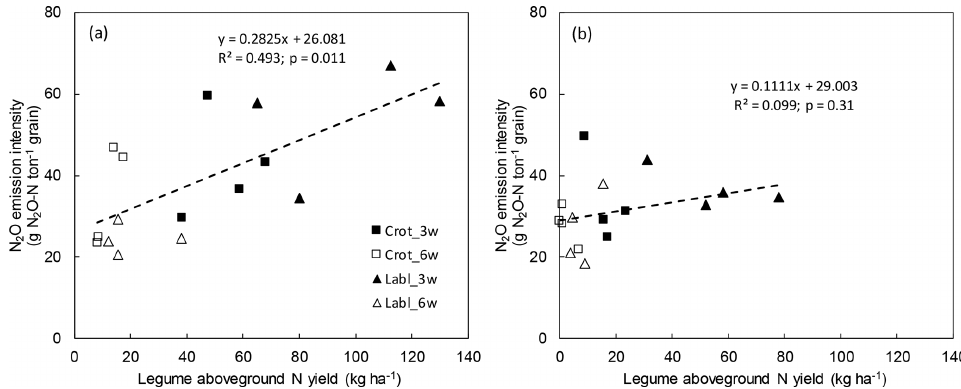
Figure 3. Relationship between N 2 O emission intensity and aboveground intercrop legume N yield in intercrop treatments in 2015 (a) and 2016 (b) . Shown are single-plot values for each treatment ( n = 4).